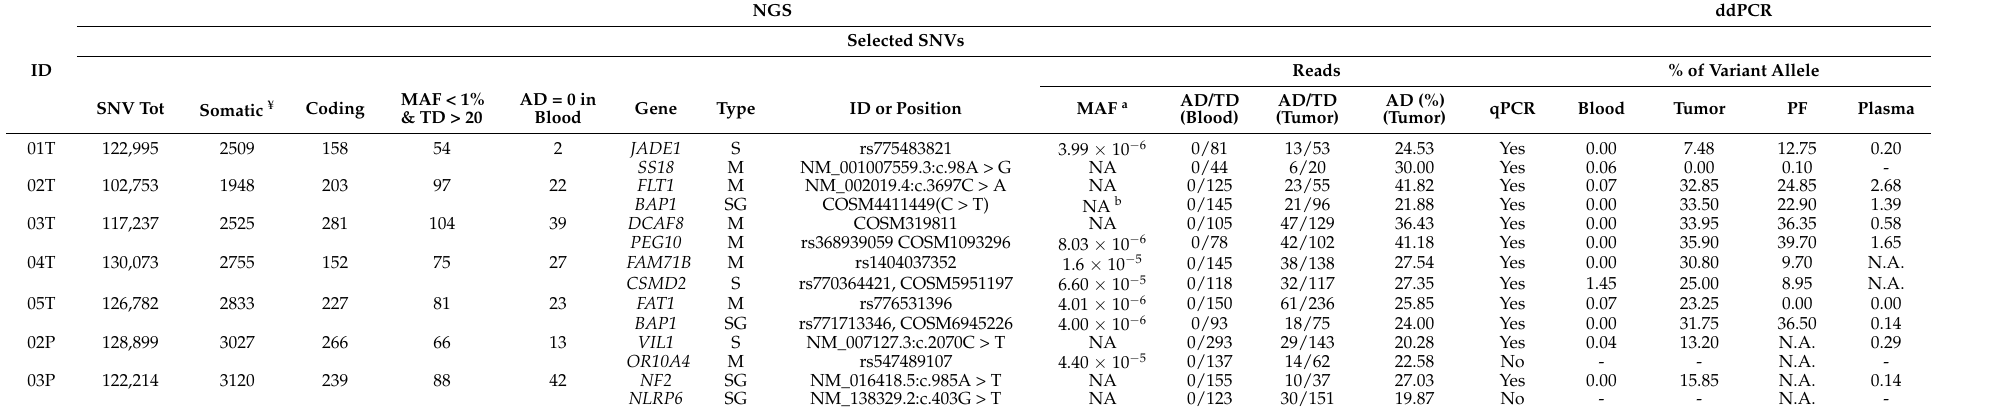
Table 2. Selected mutations analyzed for Group PT after FPT filtering and relative ASO–qPCR and ddPCR